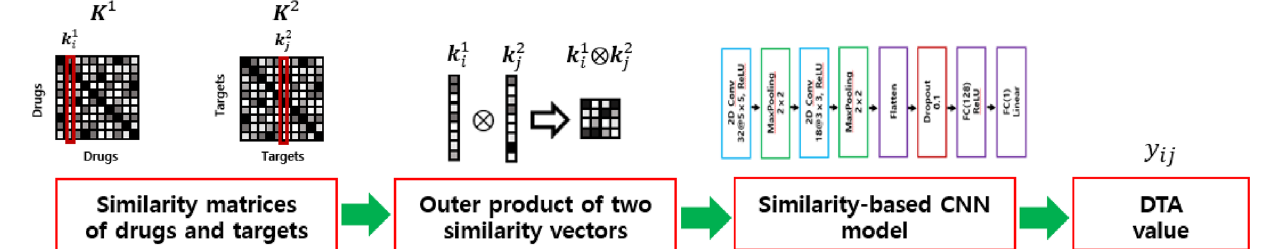
Figure 1. A workflow of the proposed SimCNN-DTA for predicting DTA values. Given an outer product of drug similarity vector and target similarity vector as input, 2D CNN is used to learn features. The architecture